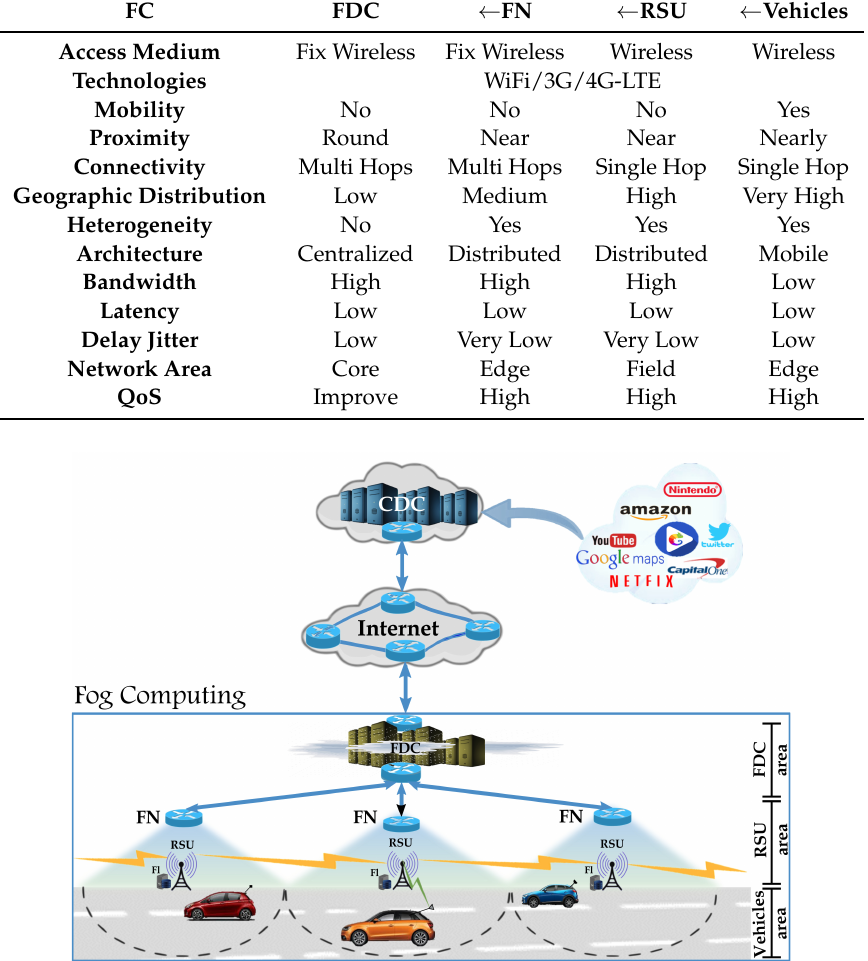
Figure 1. The overall VFC architecture. CDC: Cloud-Data-Center with the main areas; FN: Fog-Node; RSU: Road-Side-Unit; Fl: Foglet; FDC: